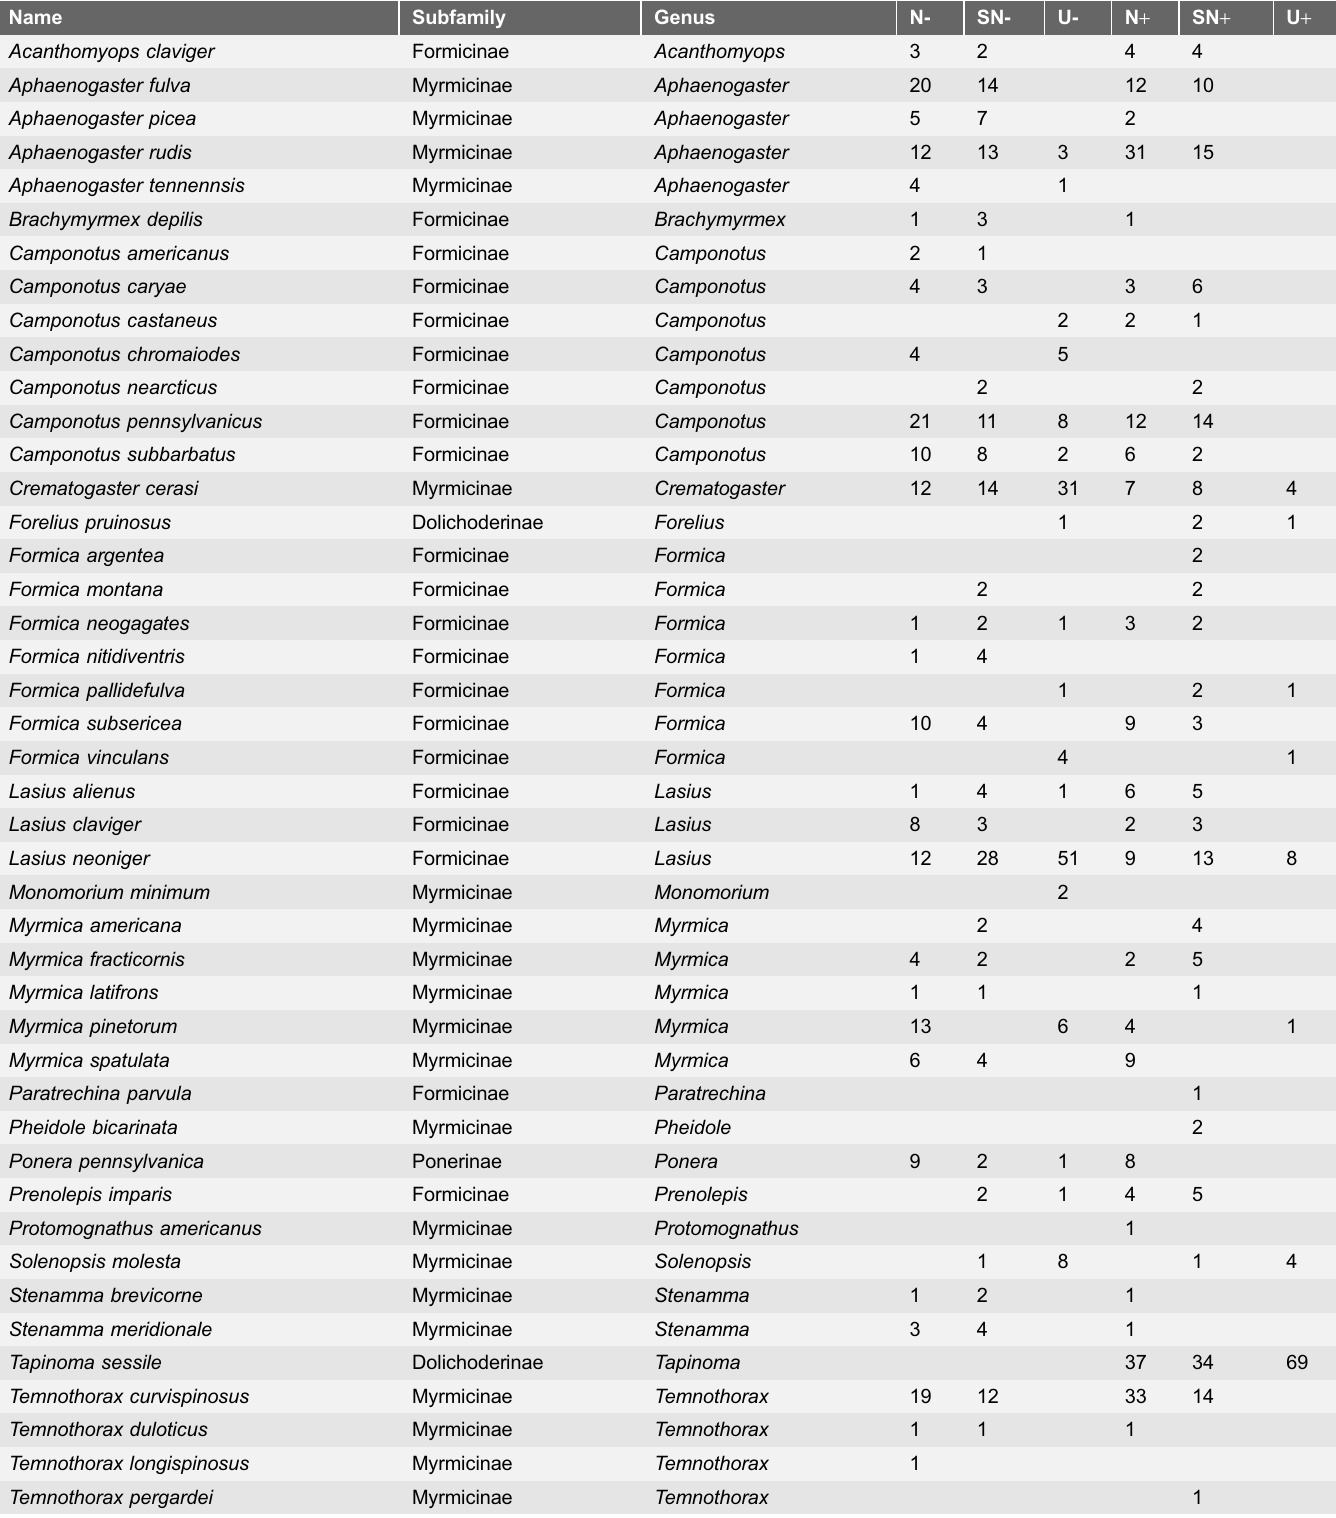
Table 1. Ant species’ numerical presence in response to